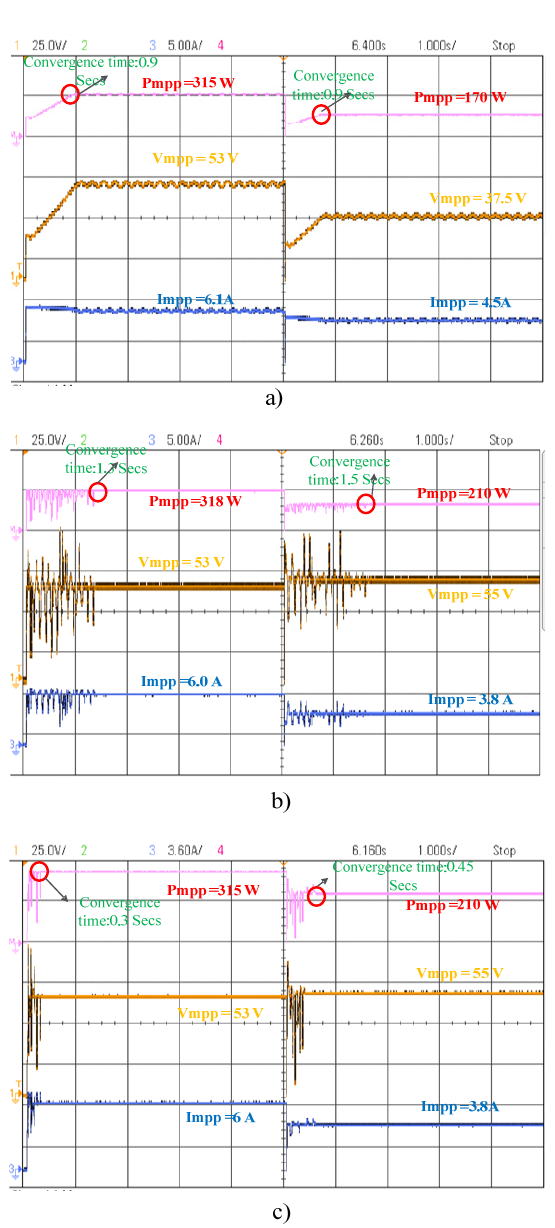
Figure 23. Experimental result for Pattern change from 2 to 4 under partial shading: ( a ) P&O, ( b ) PSO, ( c ) SHO.